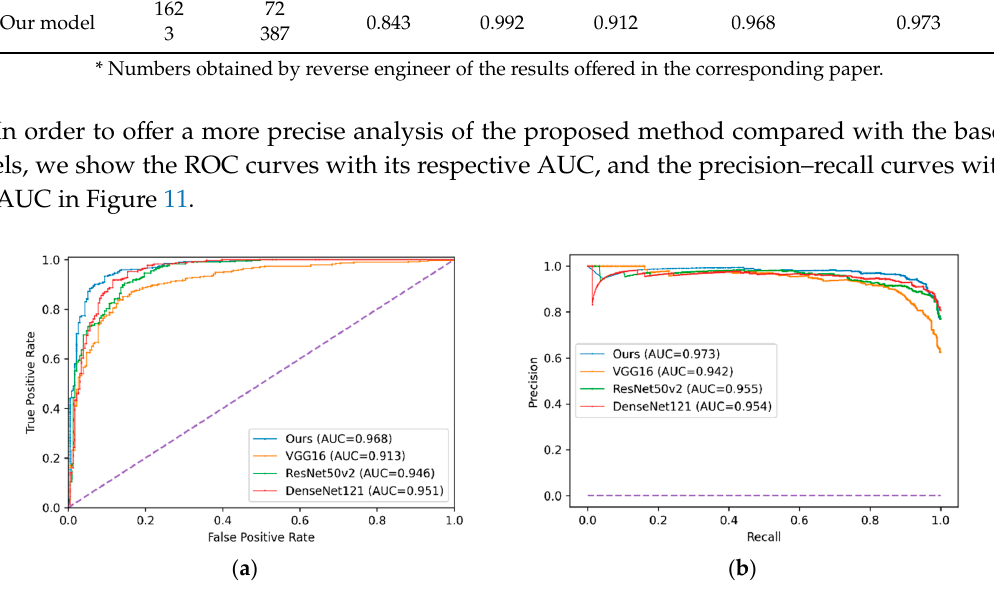
Figure 11. Metrics and curves of the implemented models where ( a ) shows the reception operating characteristic (ROC) curve and area under the curve (AUC); ( b ) shows the precision–recall curve with its respective area .